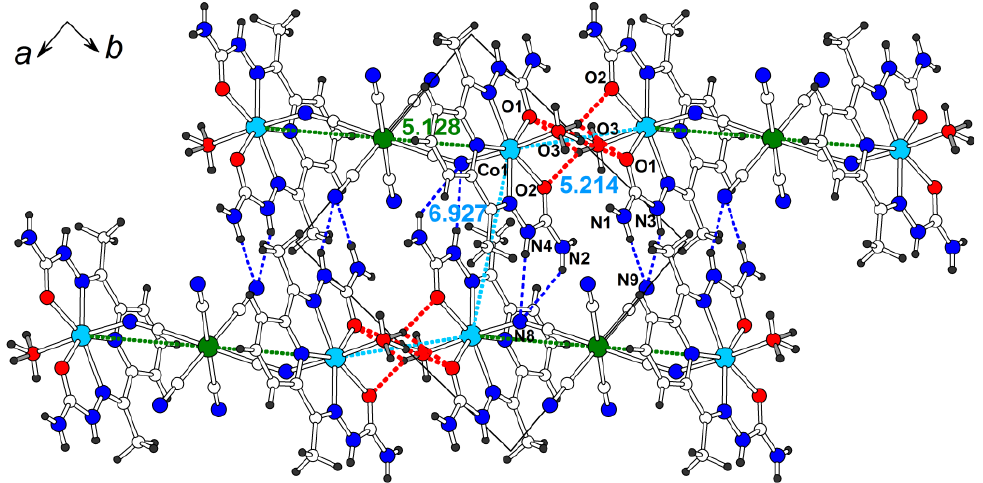
Figure 7. The ab layer in the structure 4 (solvate water and ethanol are omitted for clarity). Intermetallic distances (in Å) are shown (cyan color for Co…Co, green color for Co…Cr). Hydrogen O-H…O/N-H…N bonds are shown by red/blue dashed lines (see Table S4 for hydrogen bond geometry).